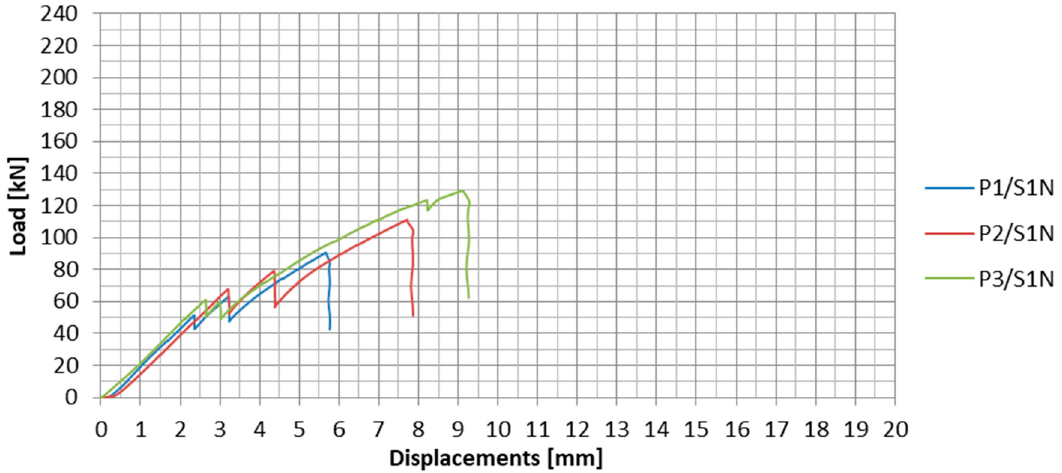
Table 2. Test results of the specimens tested in S1N series.